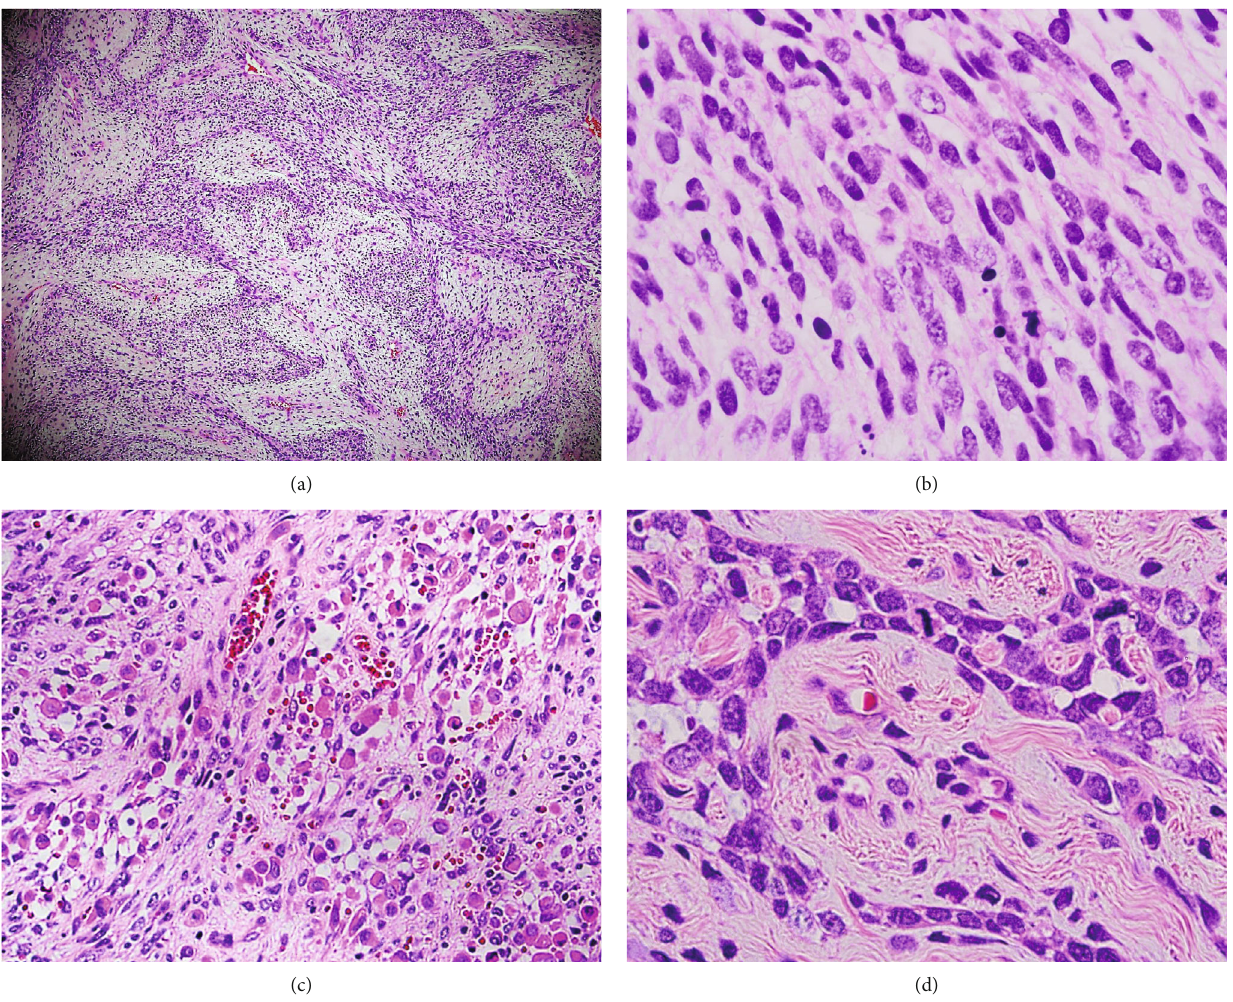
Figure 2: (a) Photomicrograph showing a neoplasm predominantly composed of spindle cells arranged in interlacing fascicles of alternating hypercellular and hypocellular areas (marbleization). H&E × 40. (b) The nuclei are pleomorphic, hyperchromatic, and mitotically active. H&E × 200. (c) Focus within the tumor shows rhabdomyoblastic di ff erentiation. H&E × 100. (d) The glandular components seen lined by malignant columnar epithelial cells. H&E ×